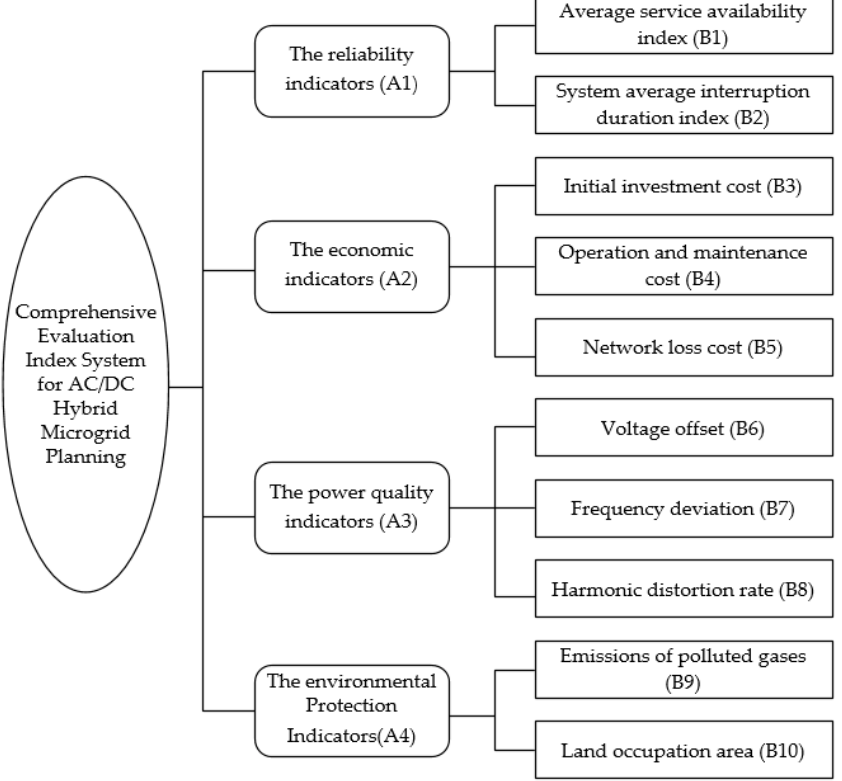
Figure 1. Comprehensive evaluation index system for AC/DC hybrid microgrid planning.